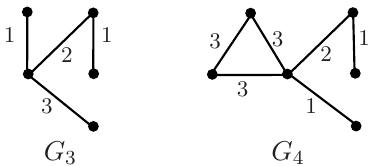
Figure 2. The graphs G 3 and G 4 with a strong proper